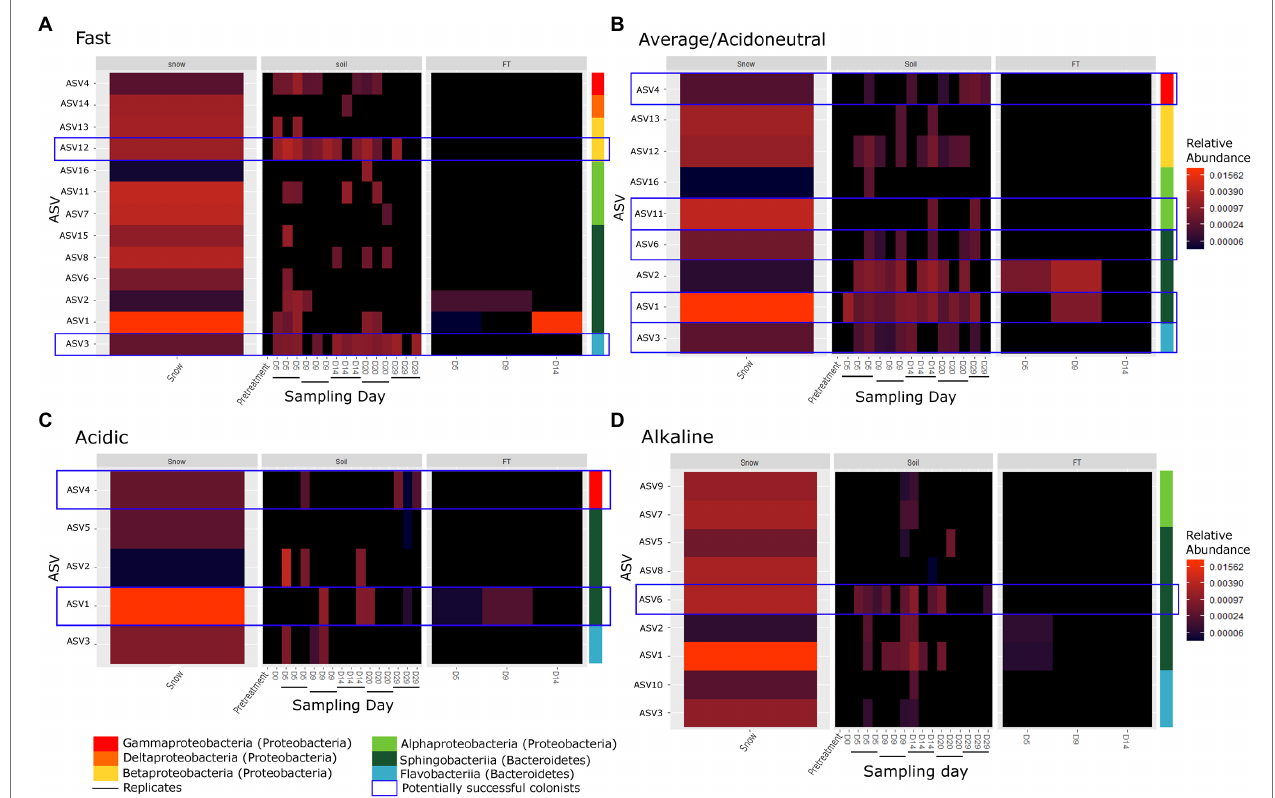
FIGURE 4 | Heatmap of invaders of (A) the fast flow, (B) the average flow/acidoneutral, (C) the acidic, and (D) the alkaline experiments where each row corresponds to an ASV. The coloured bar indicates the taxonomy associated to each ASV at the class level. Blue boxes highlight potentially successful colonists identified across multiple days and still present on D29. Black horizontal bars indicate replicate